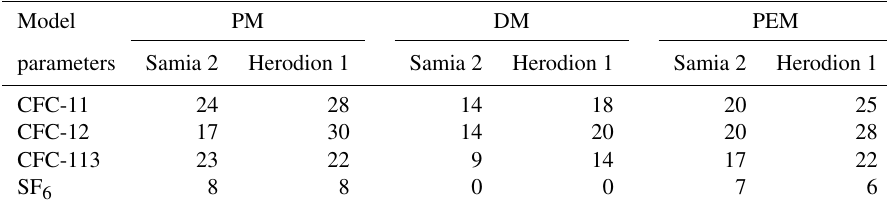
Table 3. Summary of gas delay in the unsaturated zone for each gas tracer and the different models. PM: piston flow model; DM: dispersion model; PEM: partial exponential model. For the parameters of the PEM, see Table 2.